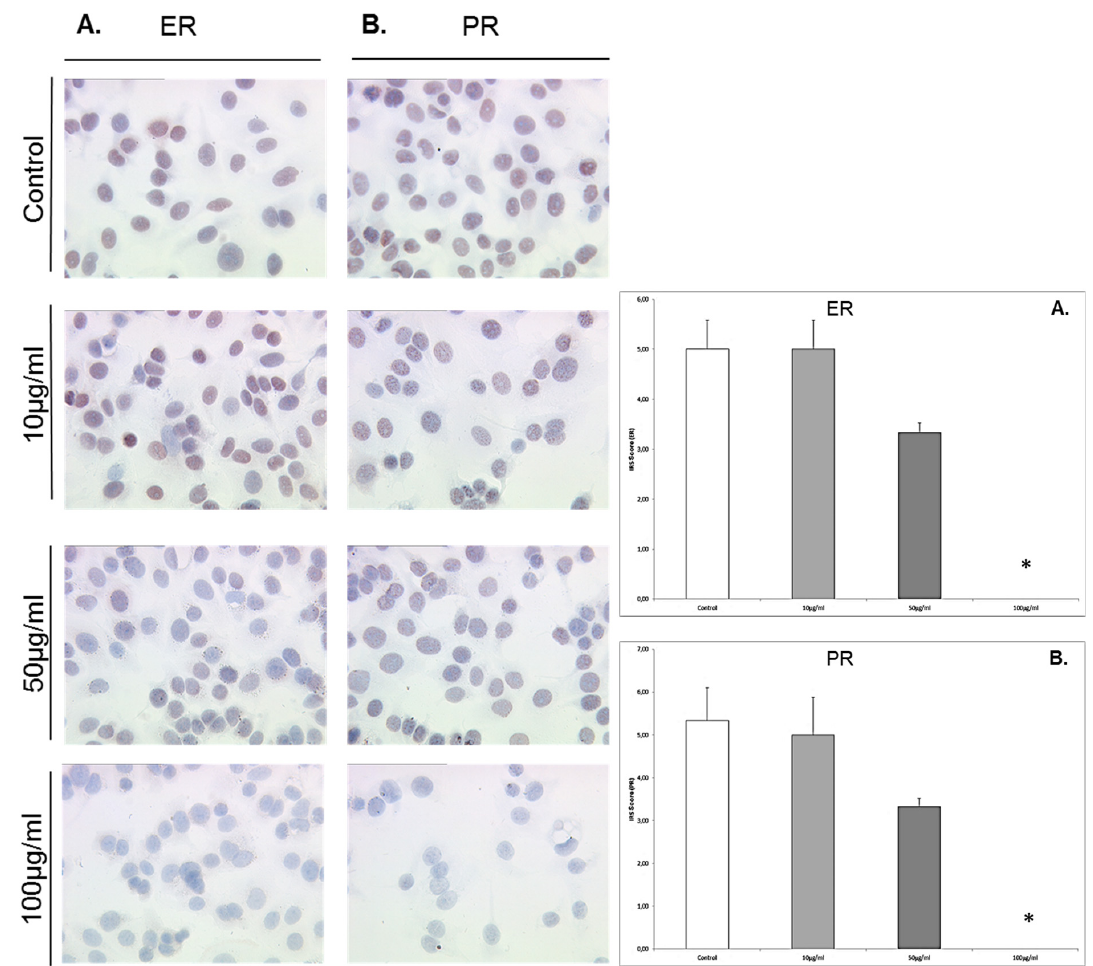
Figure 6. Representative microphotographs of MCF7 cells grown in the absence or presence of enterodiol at concentrations of 10 μ g/mL, 50 μ g/mL, and 100 μ g/mL), after immuno ‐ detection of ER ‐α ( A ) and PR ( B ) ; and presentation of the immunocytochemistry results by the semi ‐ quantitative immunoreactivity score (IRS). Significantly observations are highlighted with an asterisk.